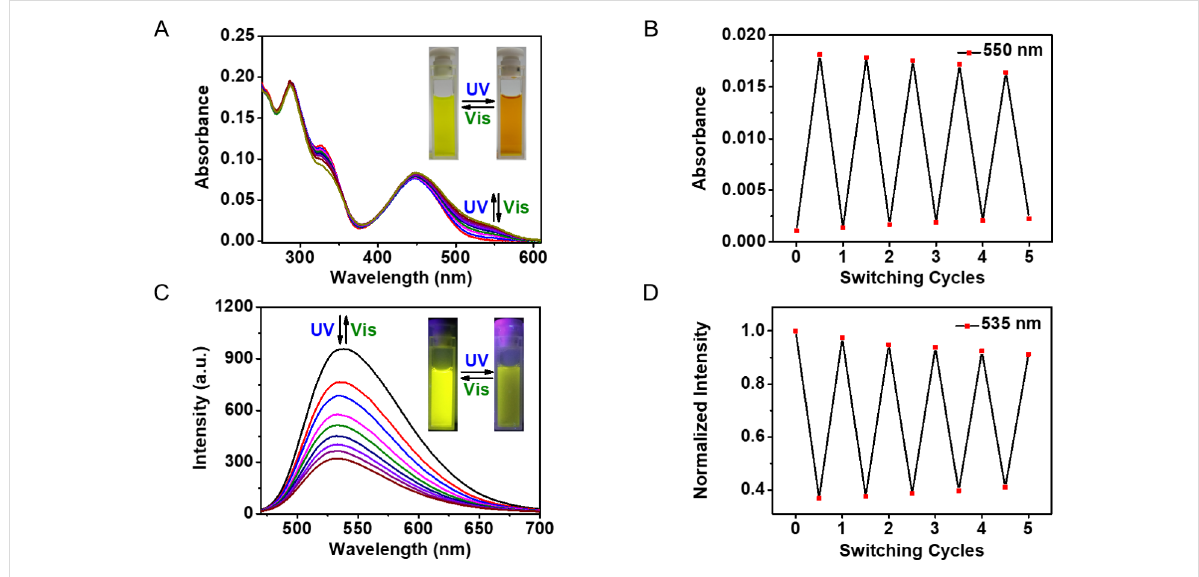
Figure 1: Absorption spectral changes (A), absorption fatigue resistance (B), emission spectral changes (C) and emission fatigue resistance (D) of reporter Glyco-DTE (1 × 10 − 5 mol/L) in PBS buffer (pH 7.4, 0.25‰ Triton X-100) upon alternating irradiation with UV (254 nm) and visible light (>500 nm). Emission spectra were produced upon excitation at 448